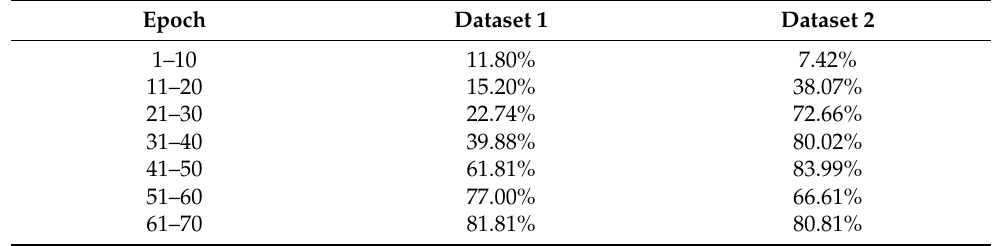
Table 4. Results for ARCH-F architecture—averaged accuracy for the range of training epochs.